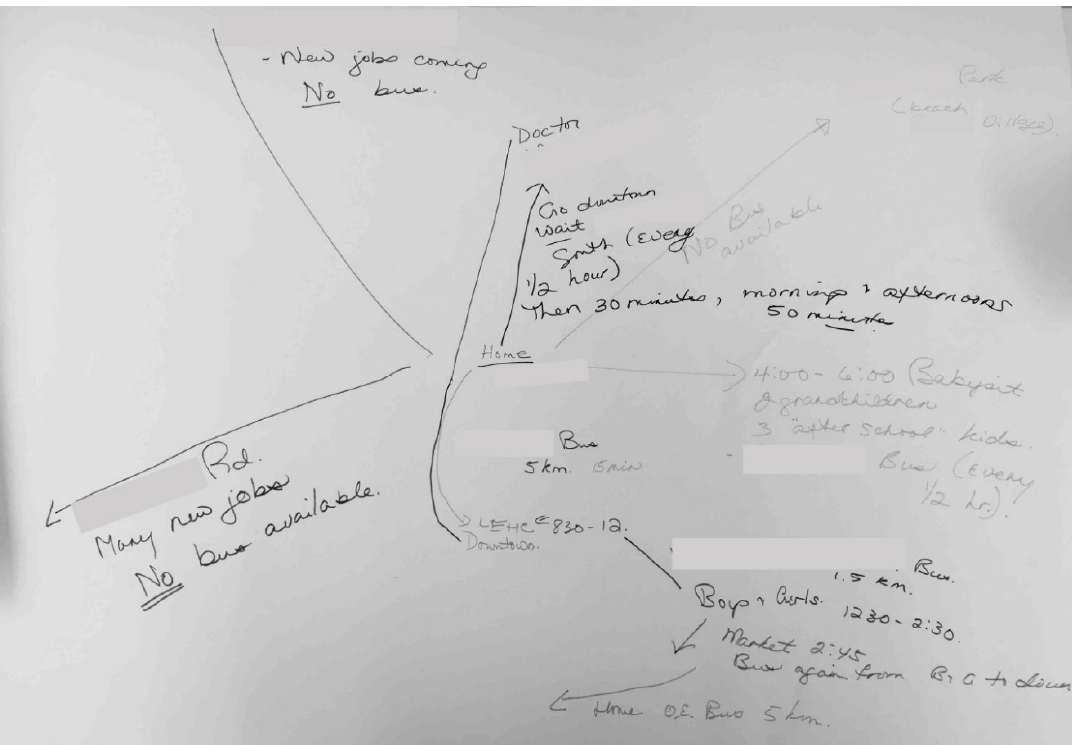
Figure 5. Helene’s map.